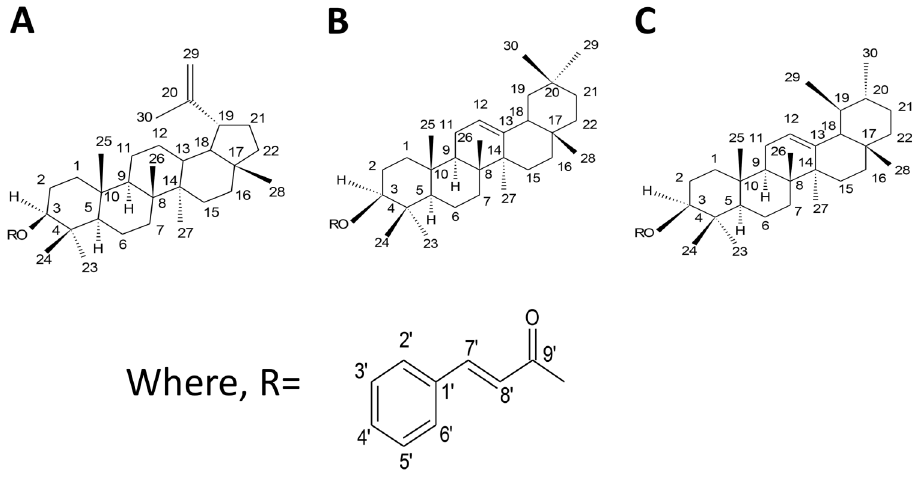
Figure 1. Structural representations for cinnamoyloxy derivatives of lupeol ( A ), b -amyrin ( B ), and a -amyrin ( C ) identi fi ed in FJNB from H. drasticus.